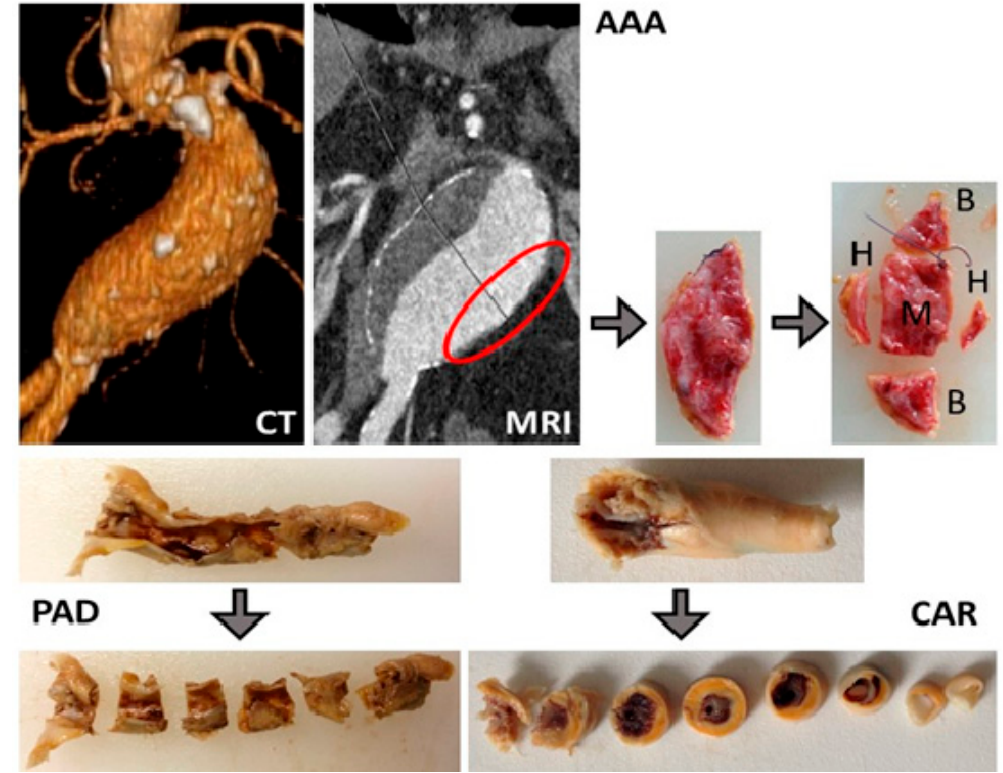
Figure 2. Examples of tissue samples collected in our Munich Vascular Biobank. CAR: carotid atherosclerotic plaques obtained from patients with high-grade carotid artery stenosis (>50%) [16] by endarterectomy (EA); PAD: atherosclerotic plaques from patients with peripheral artery disease obtained by EA [17]; AAA: aortic wall from patients with abdominal aortic aneurysm who underwent open surgical repair [18]; B: fresh frozen segments for molecular biology; H: histology; M: mechanics (tensile tests); CT: computer tomography, MRI: magnetic resonance imaging.